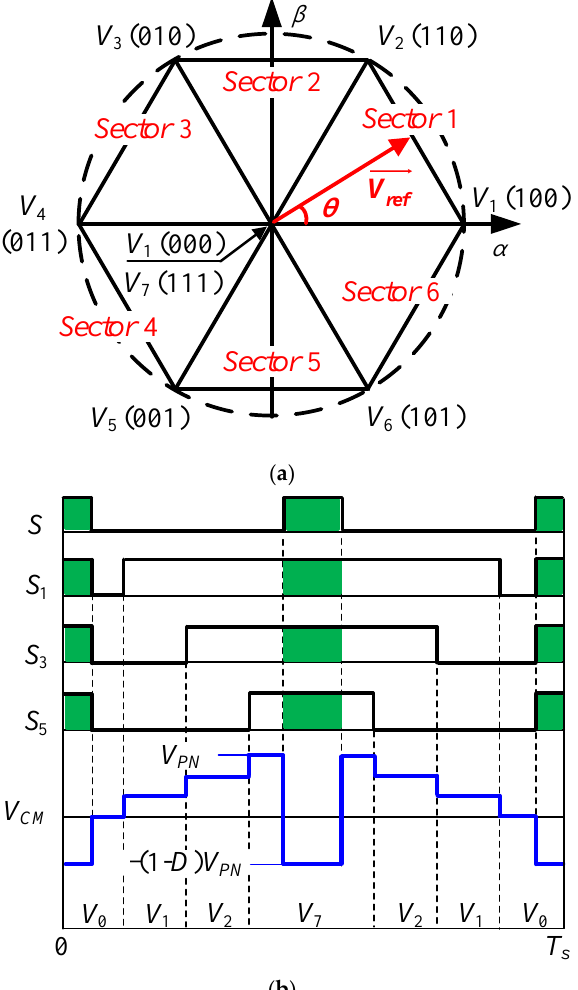
Figure 2. Three-phase AqZSI using conventional SVM method. ( a ) SVM diagram; ( b ) switching pattern in Sector